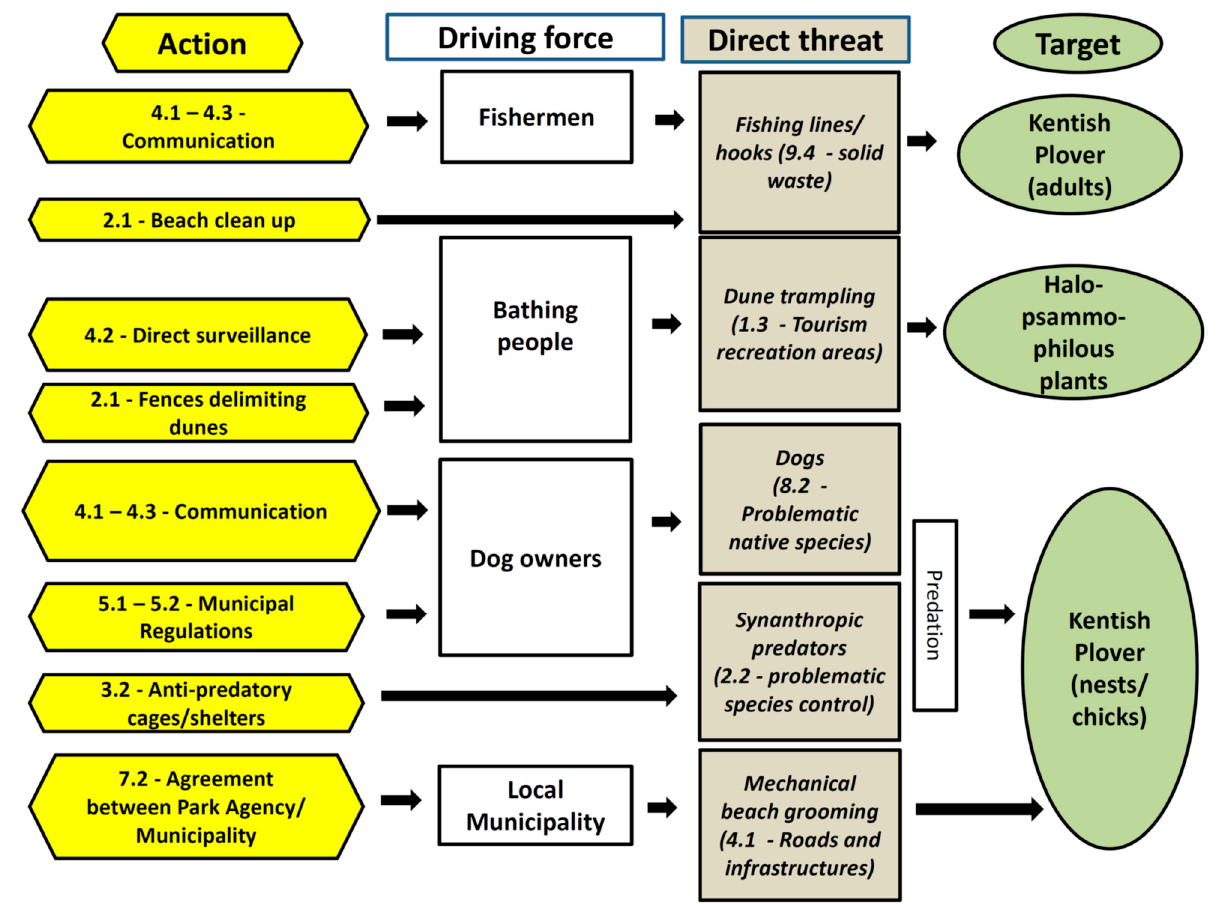
Figure 2. Threat Analysis (TAN) in the ‘Torre Flavia’ Special Protection Area, with causal chain driving forces (social actors, white boxes)—threats, (grey boxes)—targets (green circles), and measures (yellow hexagons). IUCN nomenclature of threats and conservation measures follows [8]; review in [10]. Table 1. Threat Analysis (TAN) procedure. Mean values (and ±standard deviation) in regime attrib- utes (area, intensity, and magnitude) for the human-induced direct threats selected in the ‘Torre Flavia’ Special Protection